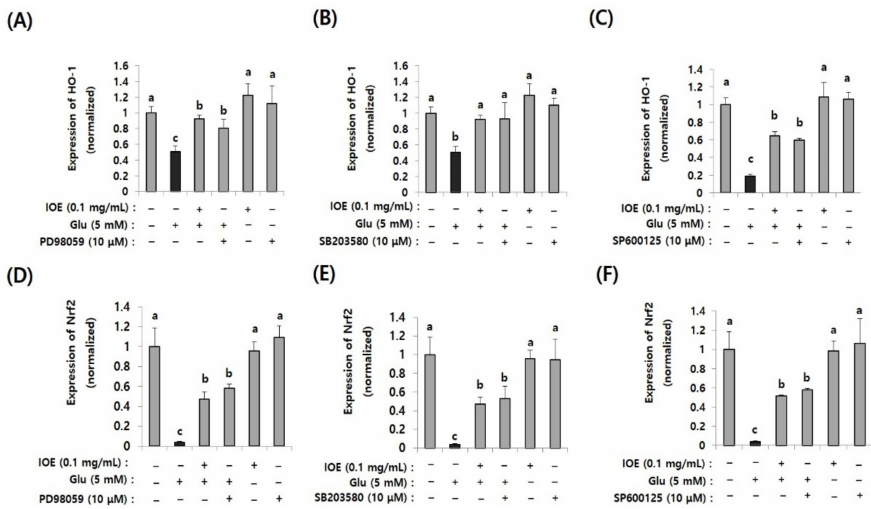
Figure 10. The glutamate-induced suppression of Nrf2 and HO-1 was restored by IOE (pretreatment for 2 h) as well as MAPK inhibitors (PD98059, SB203580, and SP600125; pretreatment for 1 h). The glutamate-induced expression of Nrf2 ( D – F ) and HO-1 ( A – C ) in HT22 cells was estimated by qRT- PCR ( n = 3). The effects of PD98059 ( A , D ), SB203580 ( B , E ), and SP600125 ( C , F ) on the expression of Nrf2 and HO-1 were estimated by qRT-PCR ( n = 3). Non-treated cells (IOE, Glu, and inhibitors-) were used for the control. Experiments were conducted in triplicate and repeated three times with similar results. Data shown are means ± SD. a: significant differences ( p < 0.05) when compared with b or c; b: significant differences ( p < 0.05) when compared with a or c.